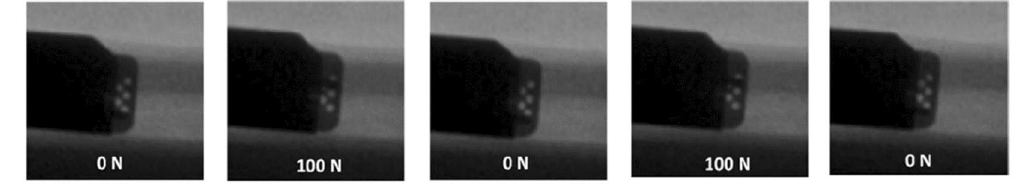
Figure 5. Radiographic images of sensor response over multiple